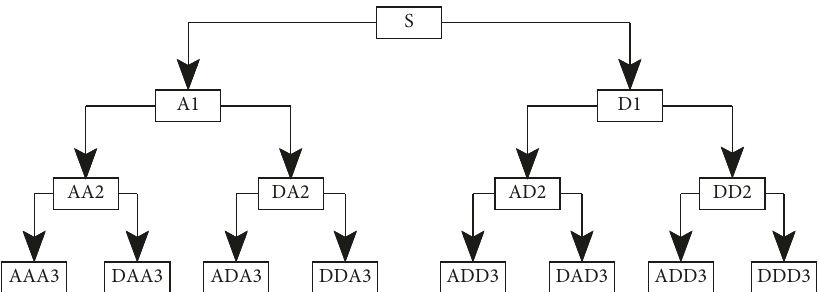
Figure 6: Diagram for signal decomposition process. A stands for low frequency, D stands for high frequency, and the numbers 1, 2, and 3 stands for decomposition levels.